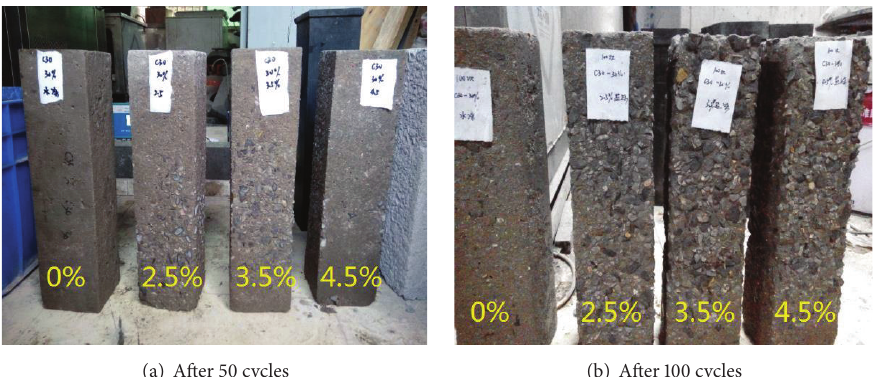
Figure 10: The C30-30% specimens after 50 and 100 salt solution freeze-thaw cycles. Note: from left to right, the concentrations of the NaCl solutions were 0% (i.e., under water freeze-thaw condition, for comparison), 2.5%, 3.5%, and 4.5%, respectively.